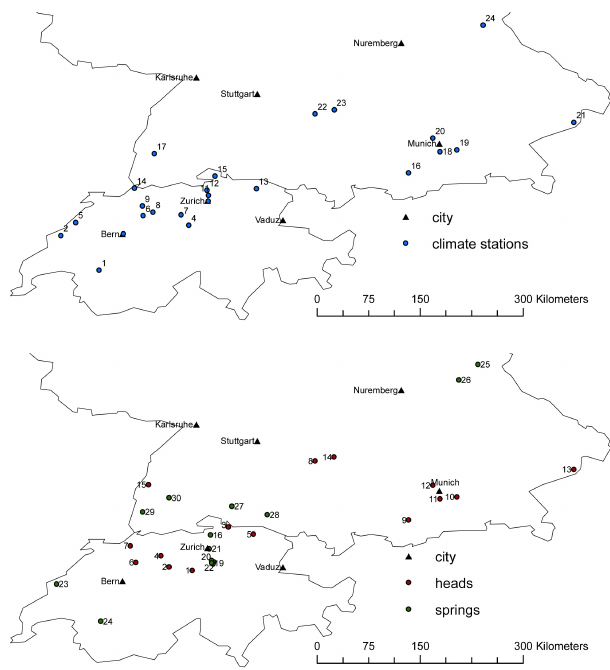
Fig. 1. Locations of the selected climatological stations (top) and groundwater monitoring sites (bottom) in northern Switzerland and southern